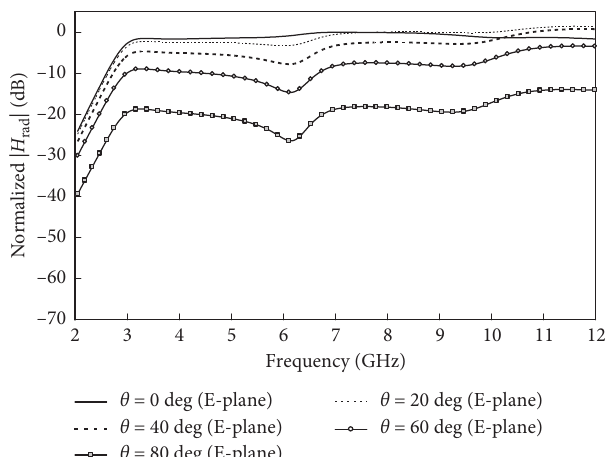
Figure 17: Simulated | H rad | of the antenna at various positions on E-plane in the upward direction.